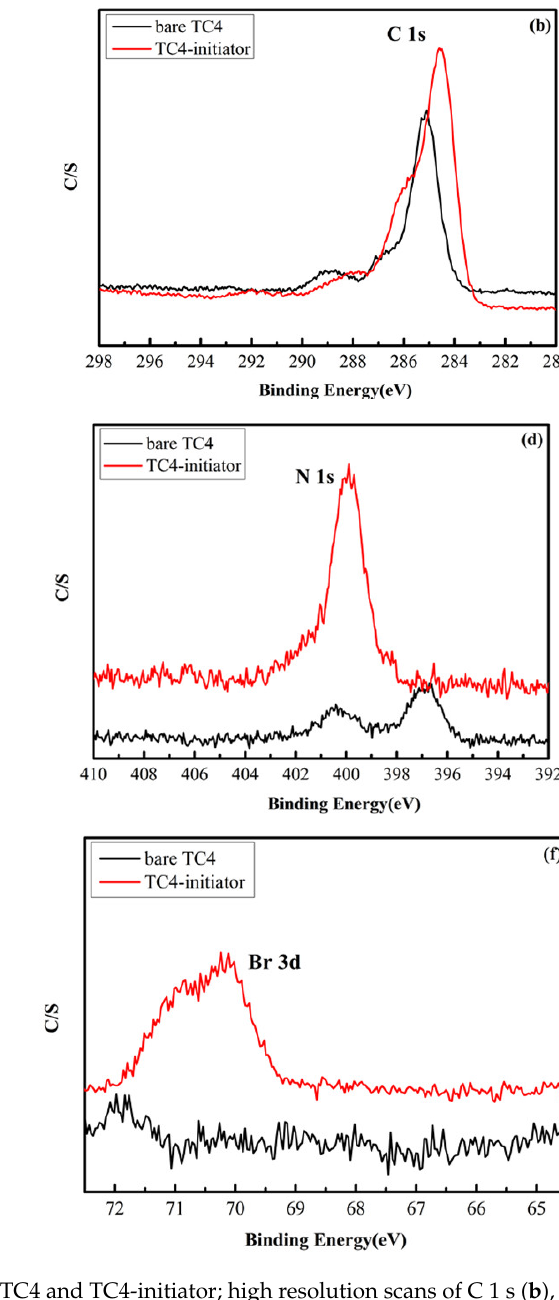
Figure 1. FT − IR spectrum of bare TC4, TC4-OH, TC4-PDA, TC4-initiator.